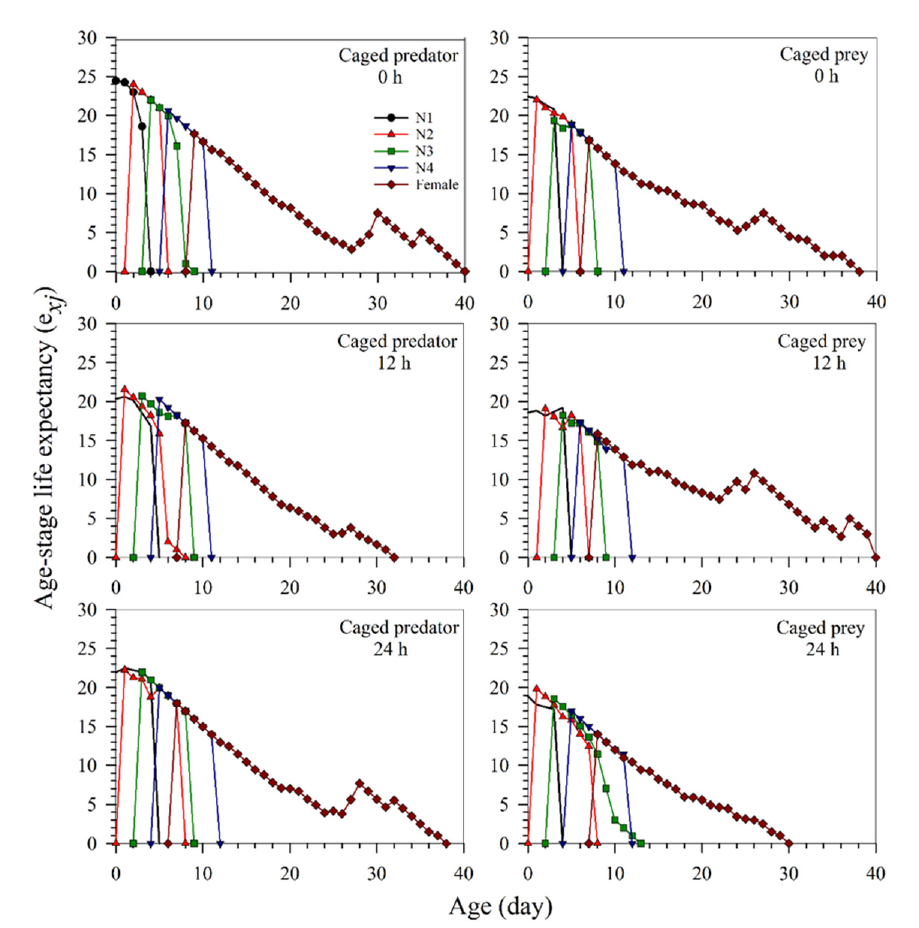
Figure 4. The age-stage specific life expectancy ( e xj ) of Sitobion miscanthi reared under predator Coccinella septempunctata risk at different exposure times (0, 12, and 24 h) with either the caged predator or caged prey treatments. N: Nymphal instar of S. miscanthi.